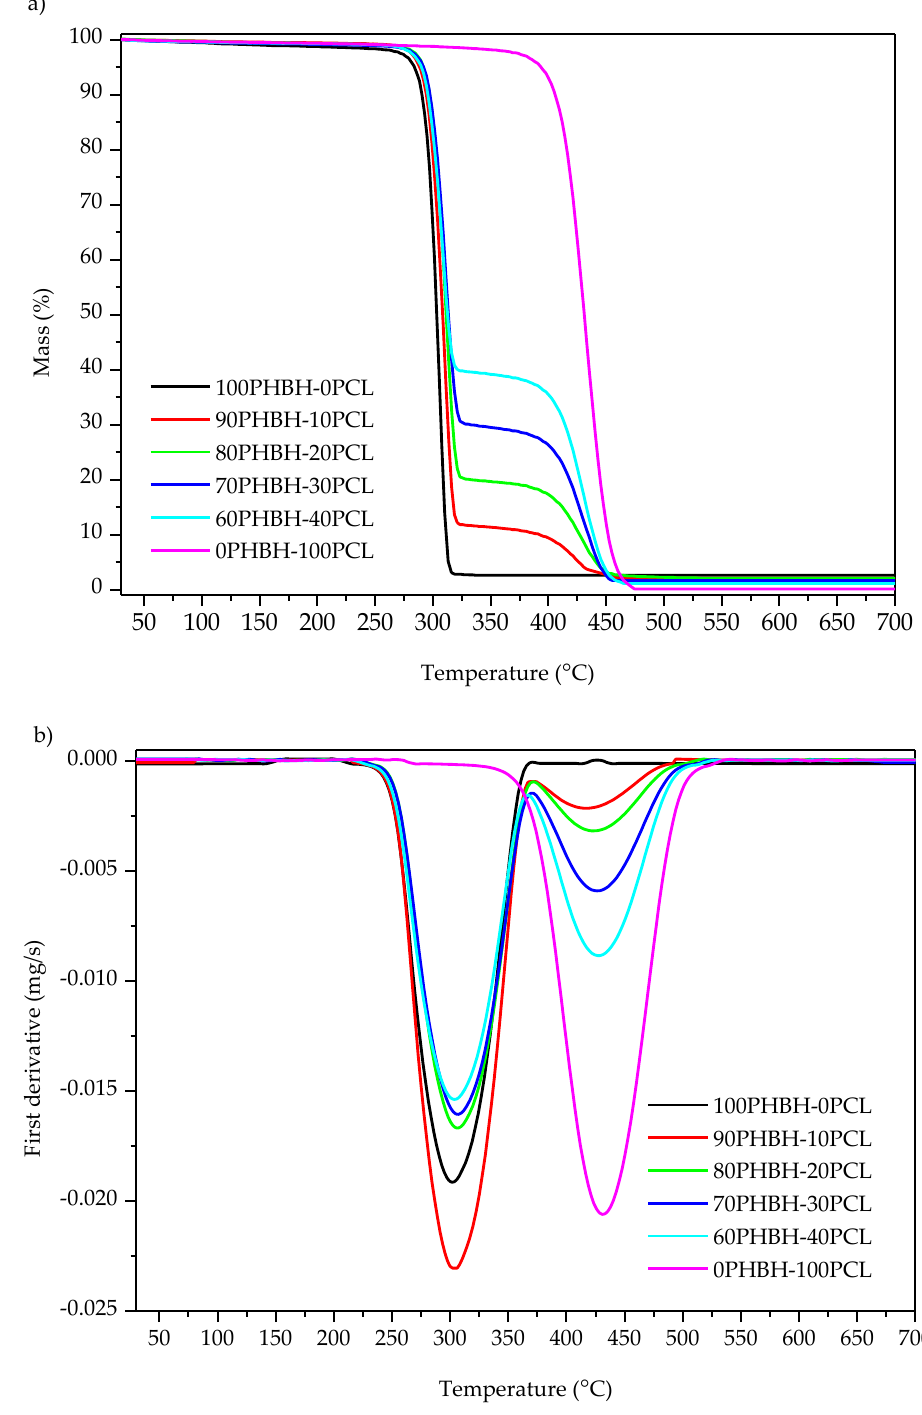
Figure 2. Comparative plot of the thermal degradation of PHBH, PCL, and PHBH/PCL with different PCL wt %. ( a ) TGA degradation curves in terms of mass loss and ( b ) first derivative of TGA thermograms.